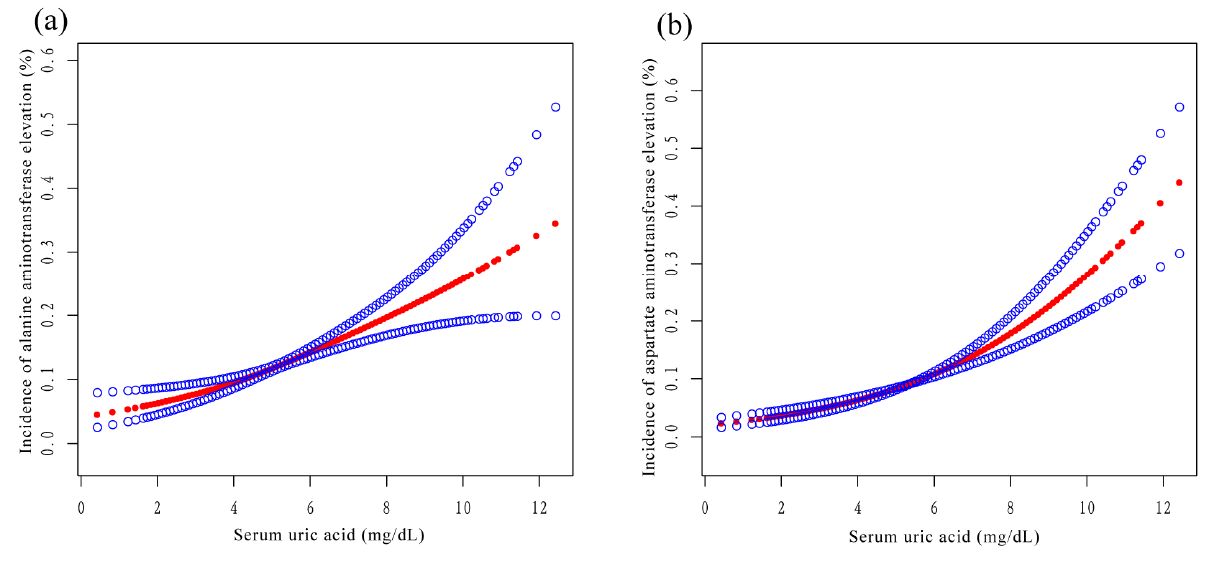
Figure 4. Relationship between serum uric acid and rate of liver enzyme elevations. ( a ) Relationship between serum uric acid and incidence of alanine aminotransferase elevation. ( b ) Relationship between serum uric acid and incidence of aspartate aminotransferase elevation. The red line represents the fitted curve, and the blue line represents the 95% confidence interval.